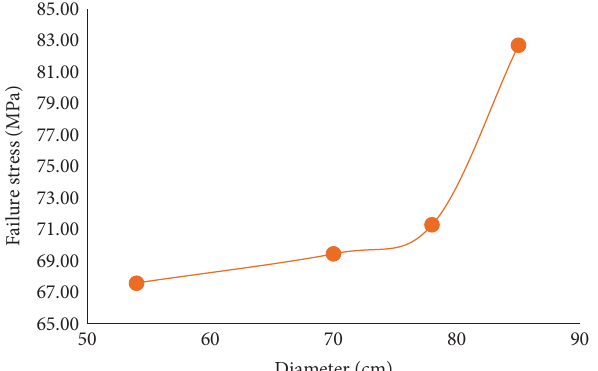
Figure 12: Curve of mean compressive failure stresses as a function of diameter in axial